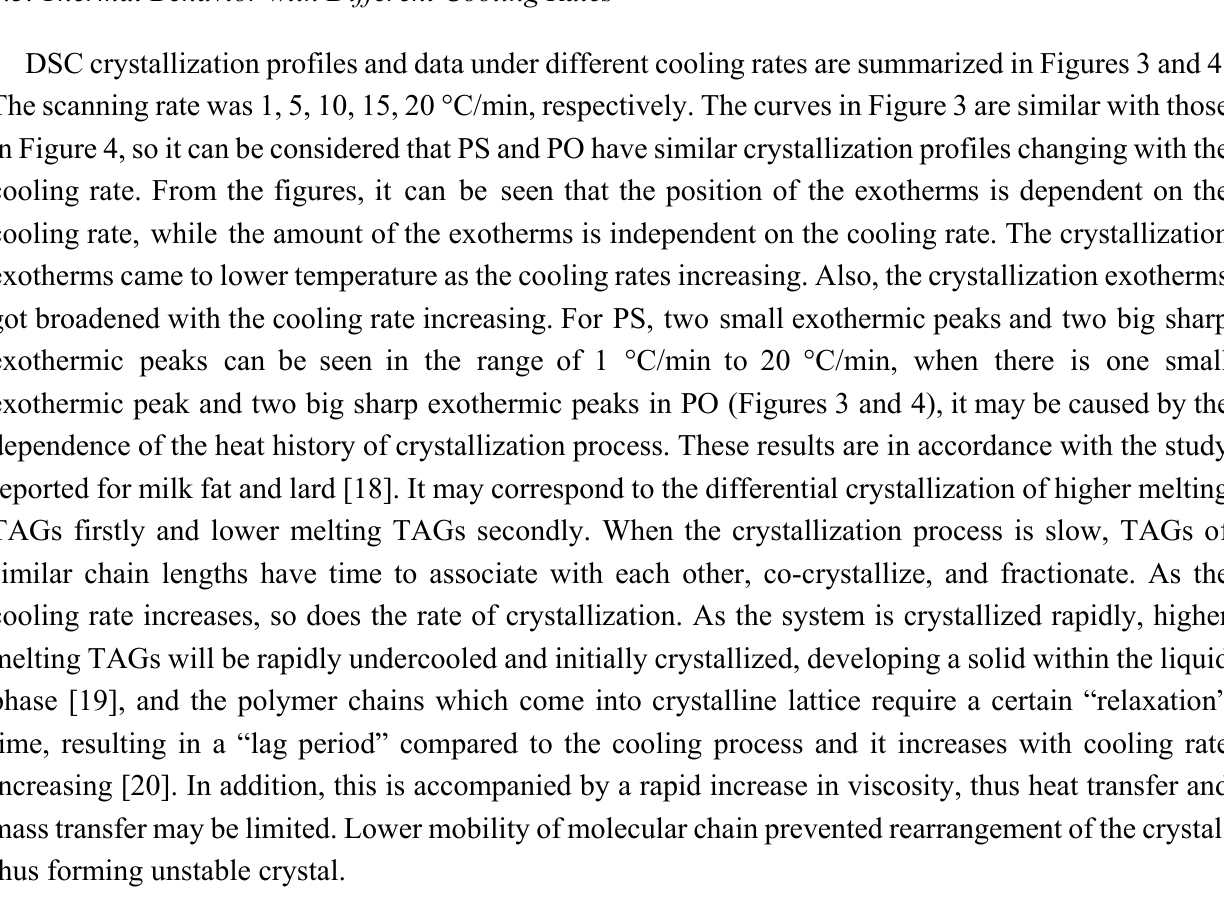
Figure 3. Crystallization curves with different cooling rate of PS: 1 °C/min ( a ), 5 °C/min ( b ), 10 °C/min ( c ), 15 °C/min ( d ), 20 °C/min ( e